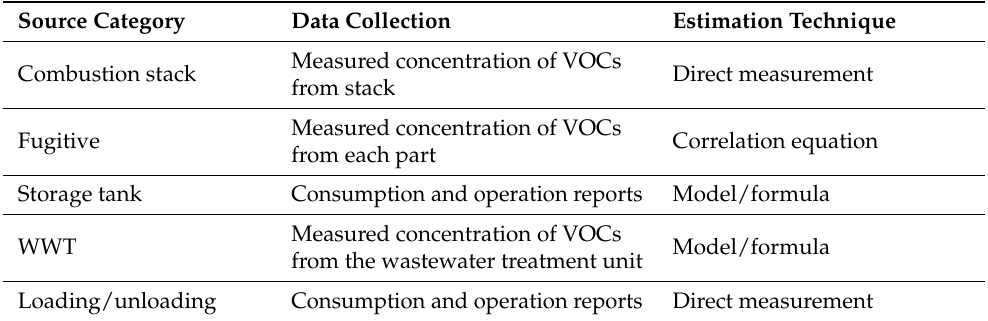
Table 2. Emission estimating techniques for each emission source. Source Category Data Collection Estimation